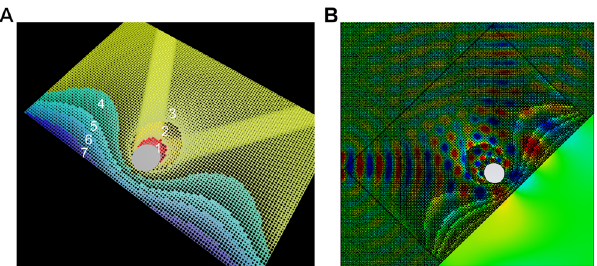
Figure 5: (A) Schematic of practical implementation scheme of the illusion device. (B) Simulated propagation pattern with practical implementation design by drilling holes on dielectric slab with spatially variant radius at 4 GHz. A Gaussian beam is illuminated to the illusion